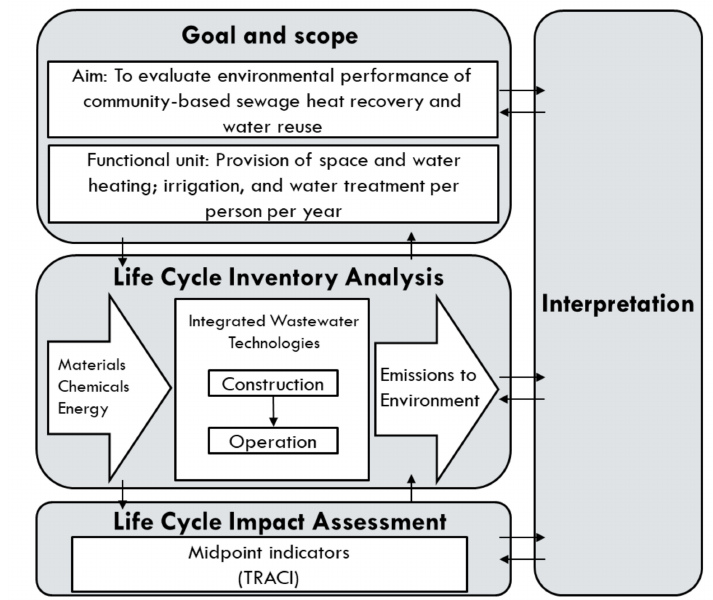
Figure 1. Overall research framework and